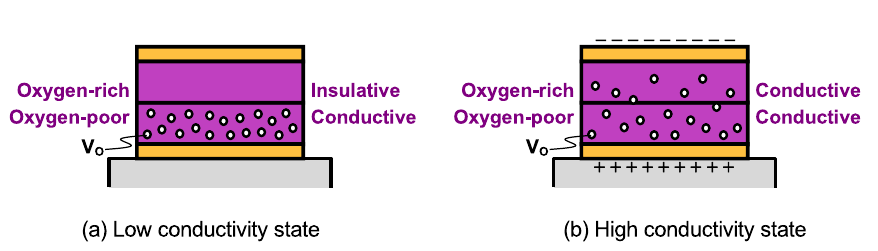
Figure 4. Working principle. ( a ) Low conductivity state. ( b ) High conductivity state. Initially, the upper oxygen-rich GTO layer includes few Vo and is insulative, which is the low conductivity state. When the voltage is applied, Vo drifts to the upper layer, and the upper layer becomes conductive, which is the high conductivity